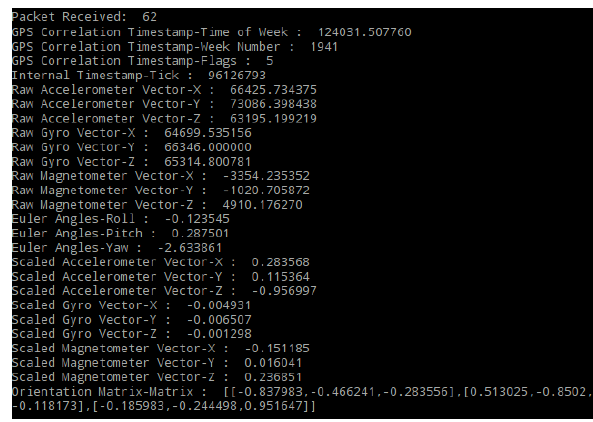
Figure 6. Data Packet received from